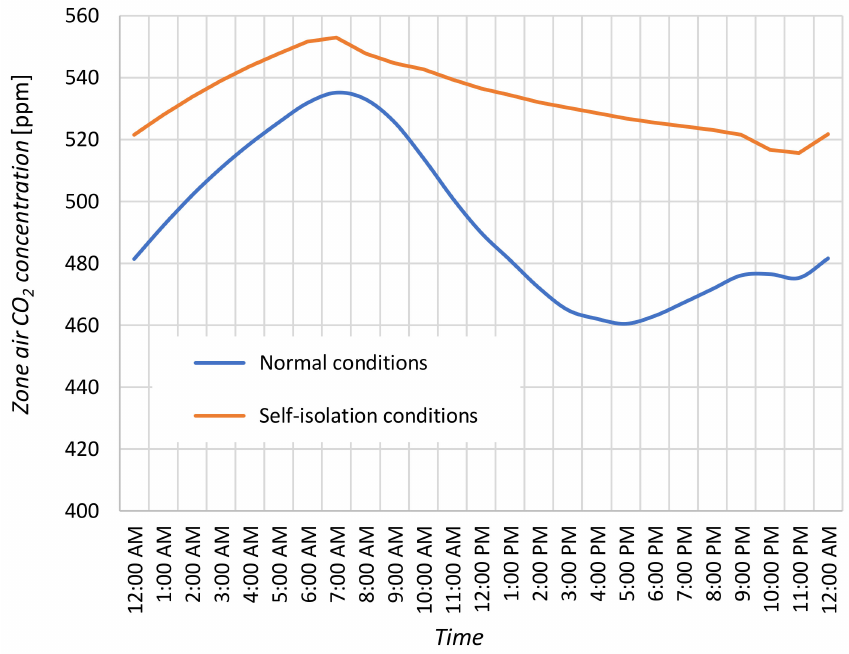
Figure 15. Change the CO 2 concentration for the presence of one person in the house.